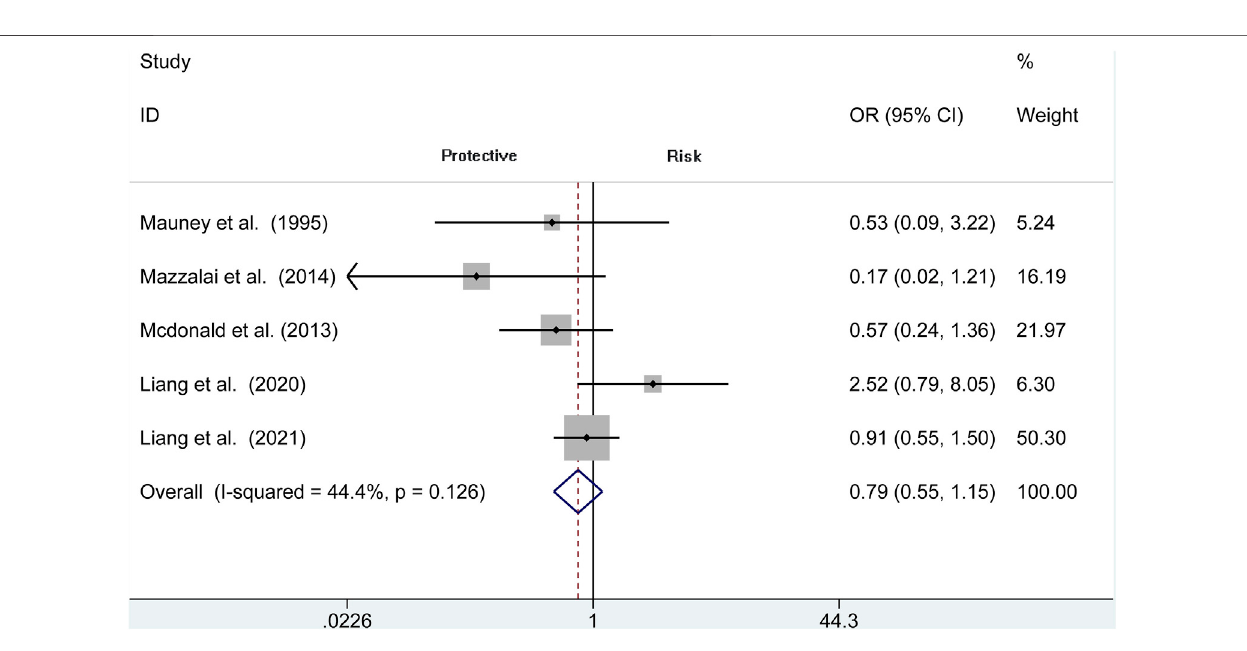
FIGURE 9 | Forest plot for meta-analysis of the incidence of transient ischemic